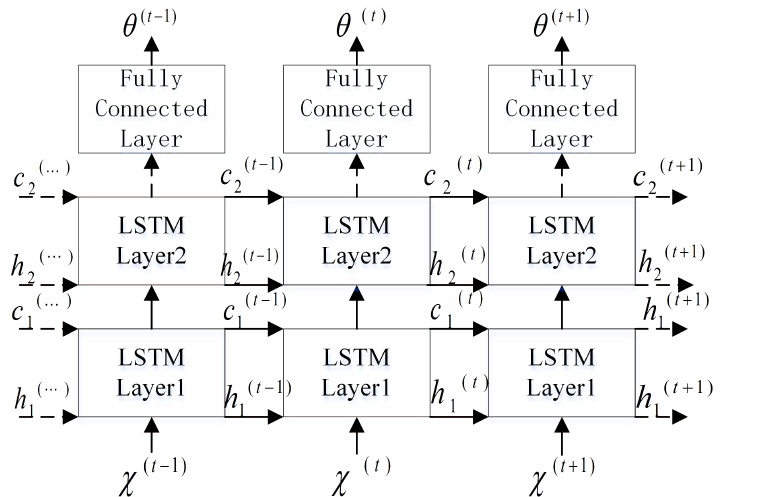
Figure 4. LSTM underwater acoustic separation network